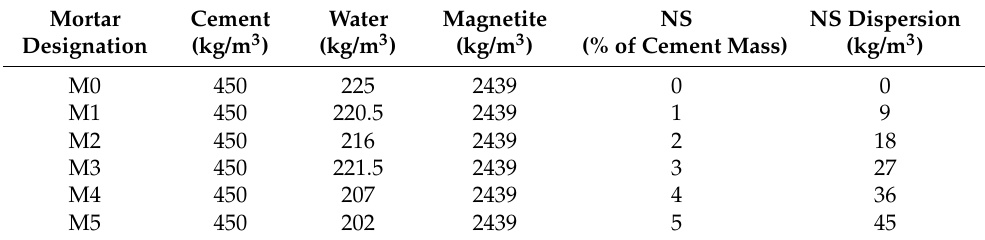
Table 1. Composition of the tested mortars.